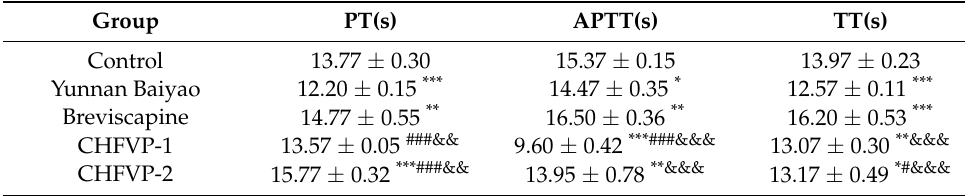
Table 8. Coagulation effects of CHFVP-1 and CHFVP-2 in vitro.